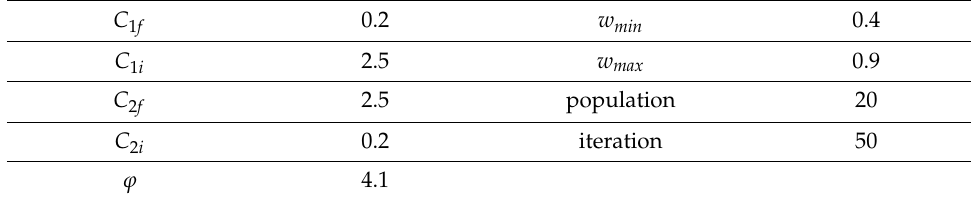
Table 1. Values selected for the proposed algorithm.